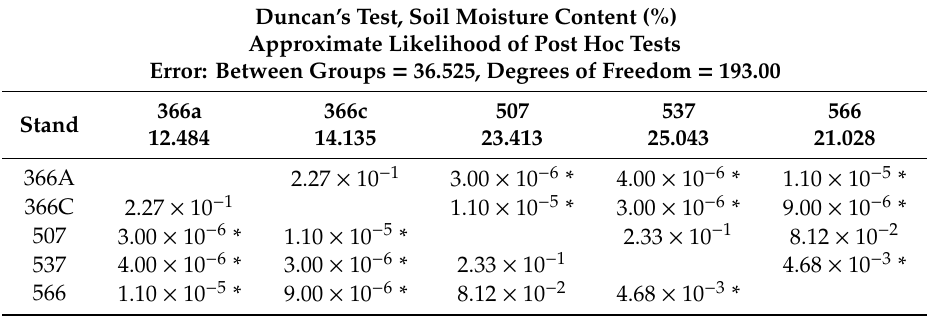
Figure 6. Average soil moisture values in individual stands and measurement locations. Table 9. Duncan’s test of soil moisture content in ruts after compaction.